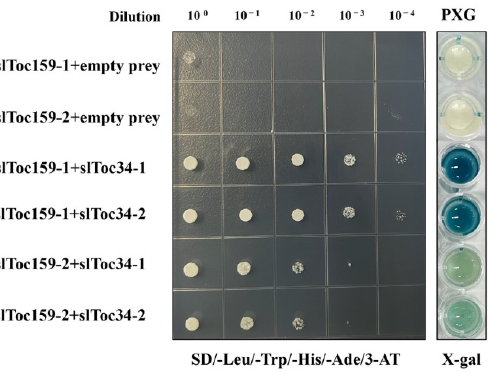
Figure 4. Pairwise yeast two-hybrid interaction studies using slToc159 as bait with Toc34 as prey and the qualitative assay of the reporter gene LacZ using X-Gal. Using slToc34-1 and slToc34-2 as prey proteins and slToc159-1 and slToc159-2 as bait proteins, they were co-transformed in pairs and co-expressed in Saccharomyces cerevis strain NMY51.SD-LW) and selective protein interaction medium (i.e., SD-LWHA/3-AT with 10 mm 3-aminotriazole quadruple selective medium). Before photography, the bacterial solution was spot-connected on a petri dish and incubated at 30 ◦ C for 6 days (SD-LWHA/3-AT). A PXG assay of the reporter gene LacZ using X-Gal as a